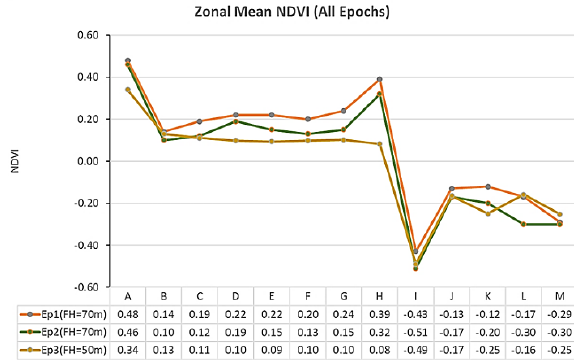
Table 8. Points pair RMSE (pixels) of many-to-one registration Band Combination